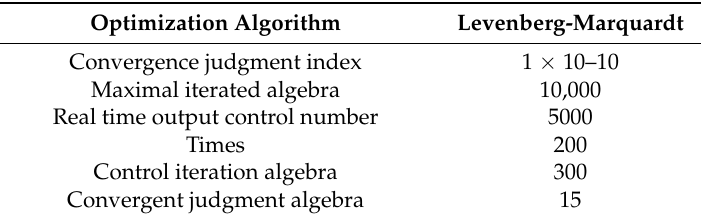
Table 10. The optimization settings.